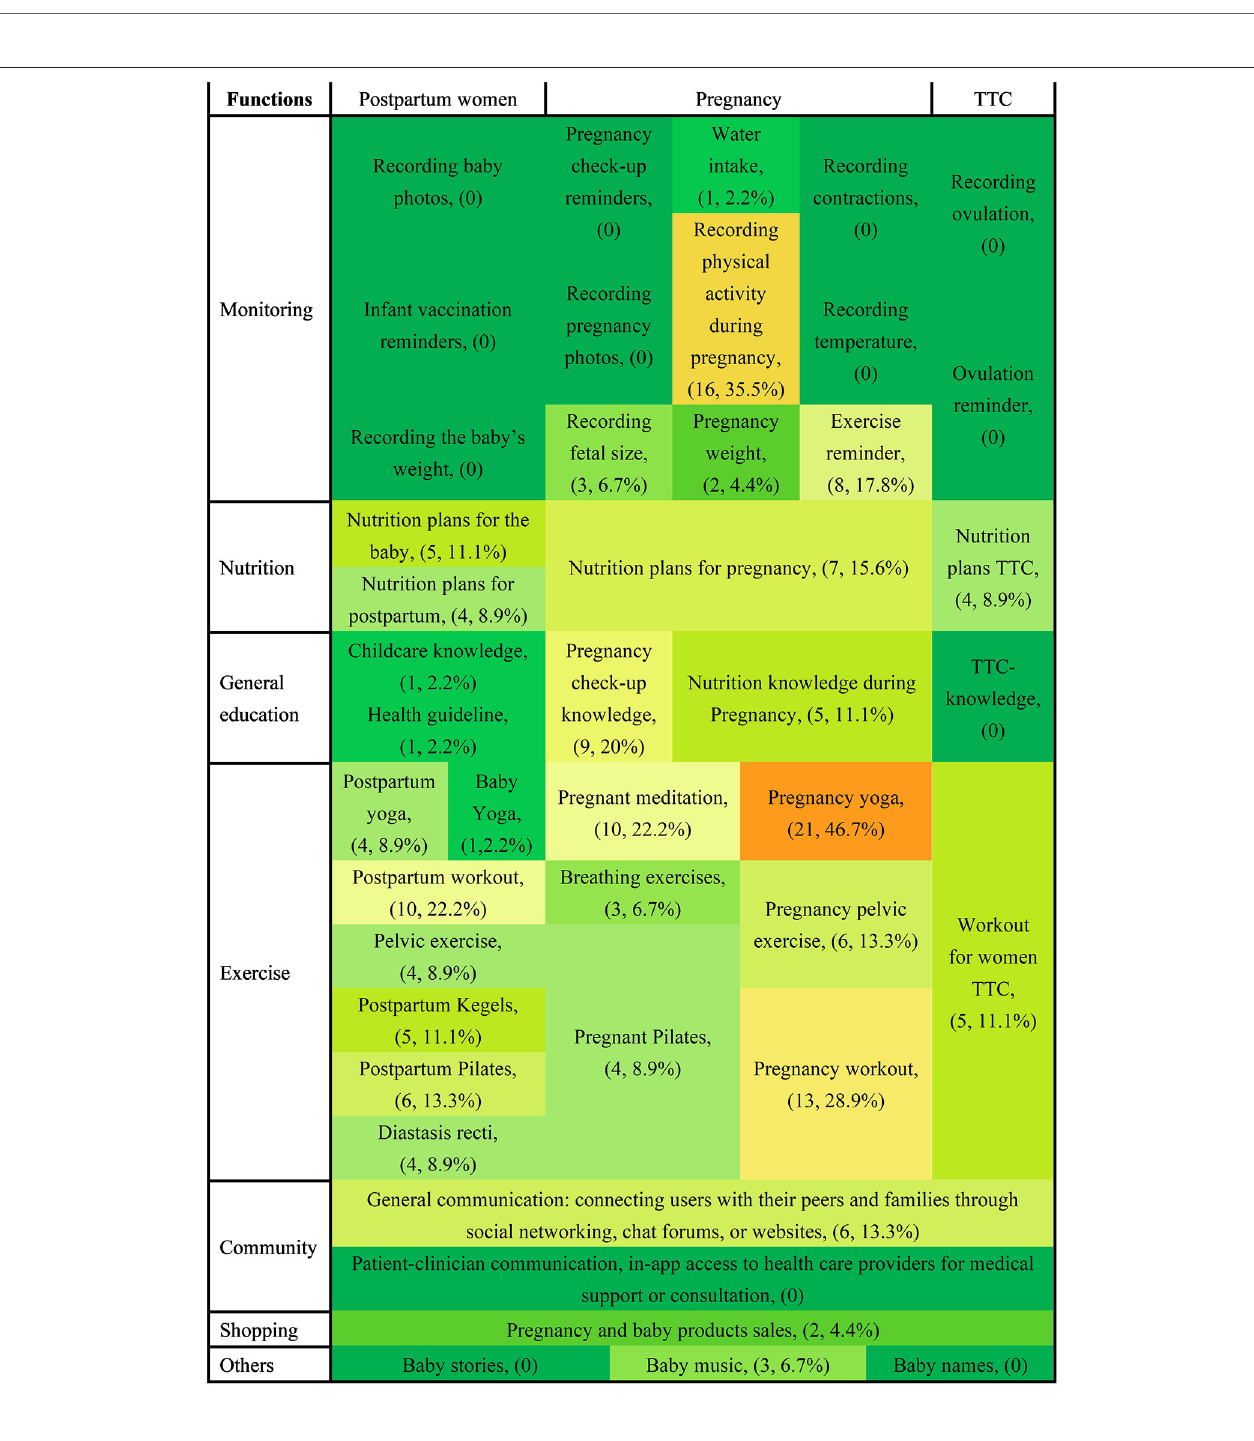
FIGURE 3 | Heat map of features of the 45 US mobile apps for pregnancy and postnatal care. TTC, trying to